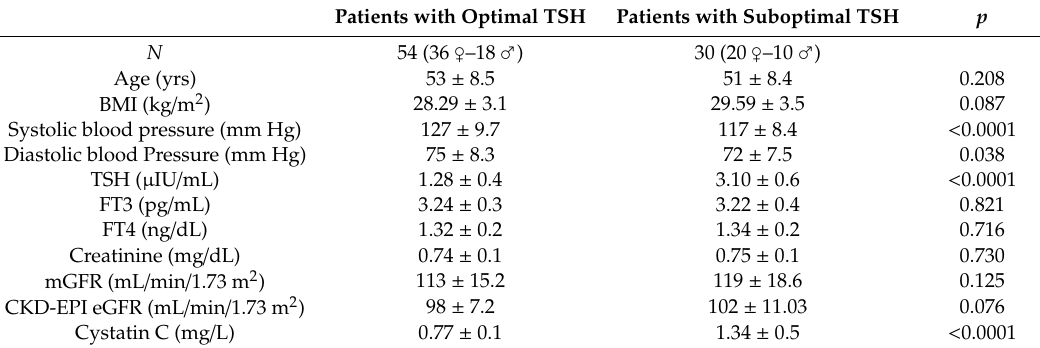
Table 2. Characteristics of the study cohort in relation to serum thyroid-stimulating hormone (TSH) levels. Patients with Optimal TSH Patients with Suboptimal TSH p N 54 (36 –18 ♀